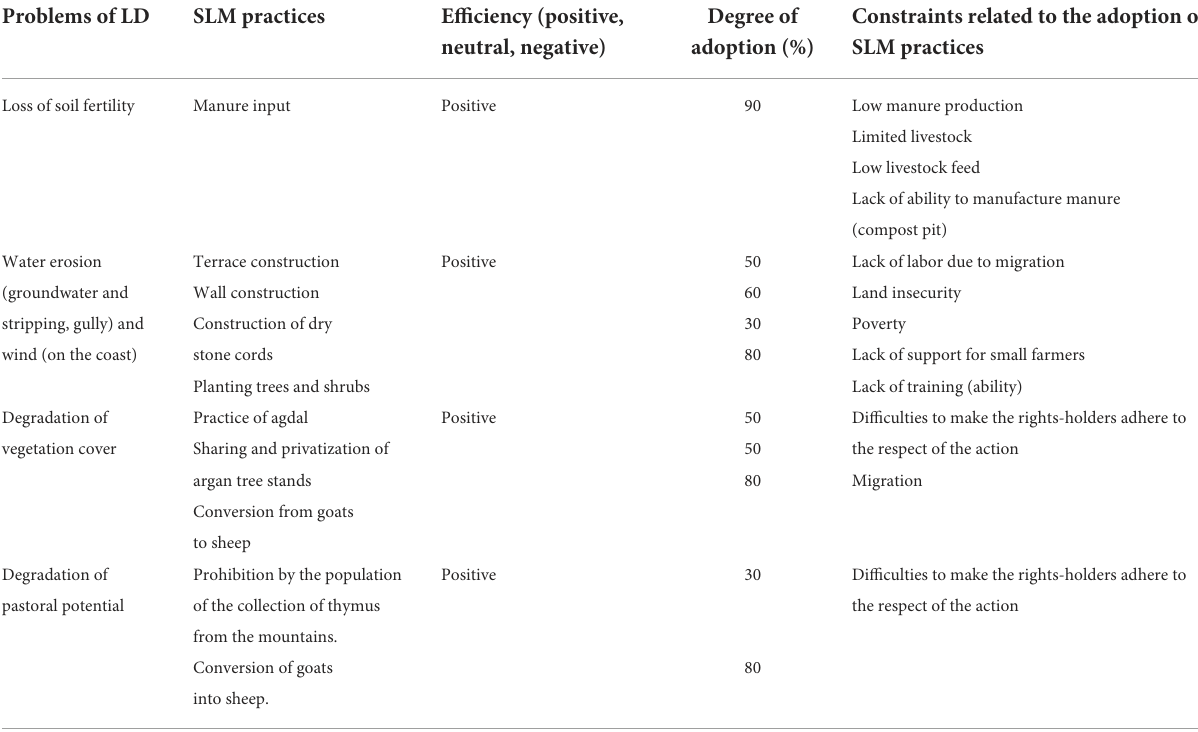
TABLE 3 Adoption of SLM good practices addressing problems of